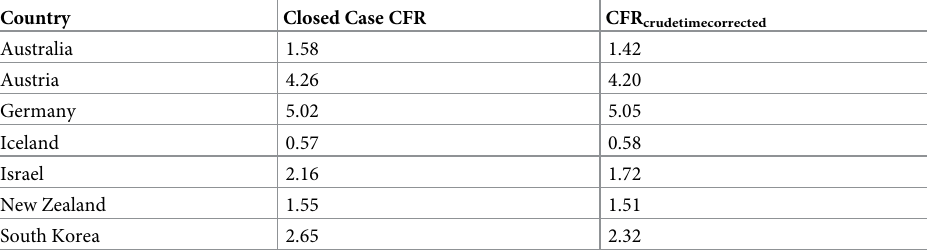
Table 2. Comparison of the time corrected CFR crude values calculated using the closed case convergence method versus the standard time to fatality time correction method [8–12, 14, 15,